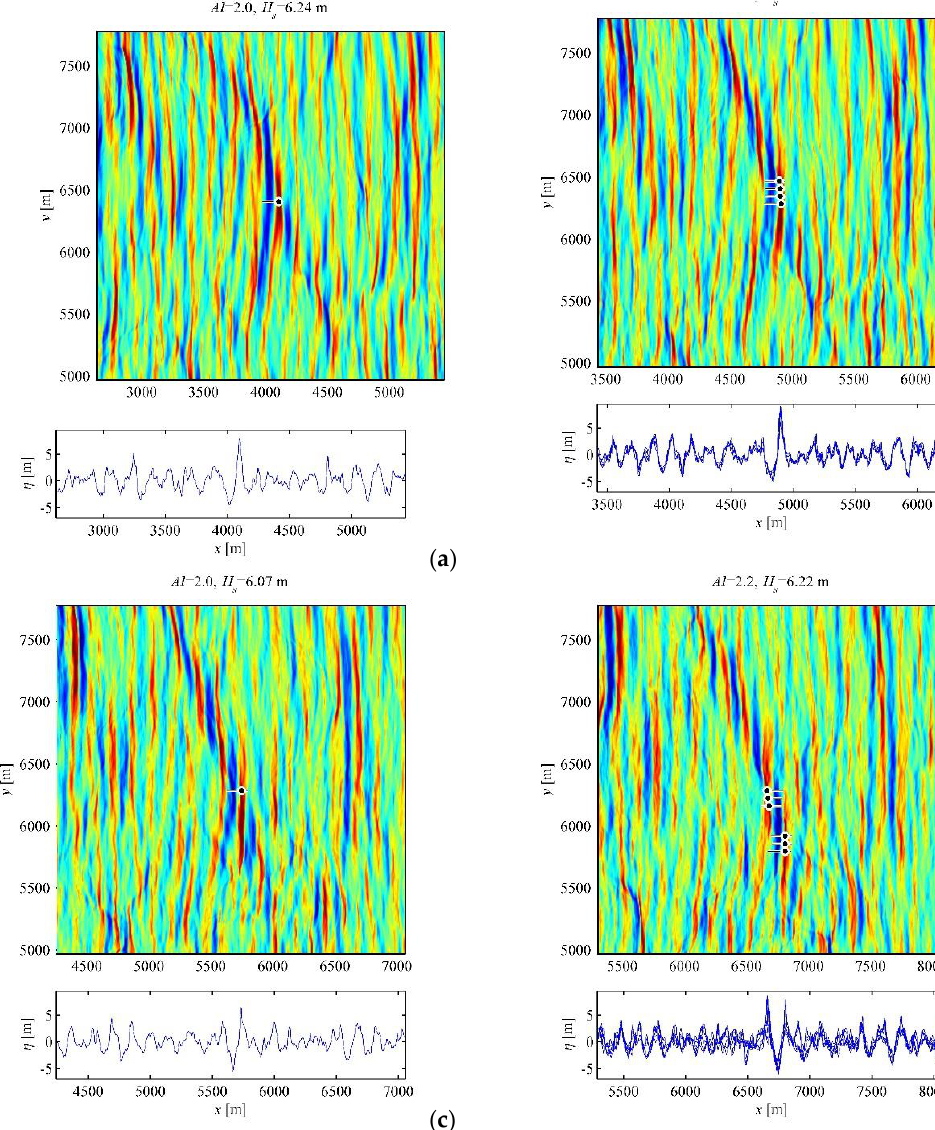
Figure 5. Snapshots of the surface in the co-moving frame (upper part) and the corresponding longitudinal wave sections (lower part) during a long-living rogue wave event from the series E 12 . The sections are taken along the points where rogue waves are detected, shown on the surfaces by circles with strokes. The circles show locations of the rogue wave crests; the strokes show directions to the deep troughs. The snapshots correspond to the following instants of time: ( a ) 642.5 s; ( b ) 732.5 s; ( c ) 825 s; and ( d ) 942.5 s.